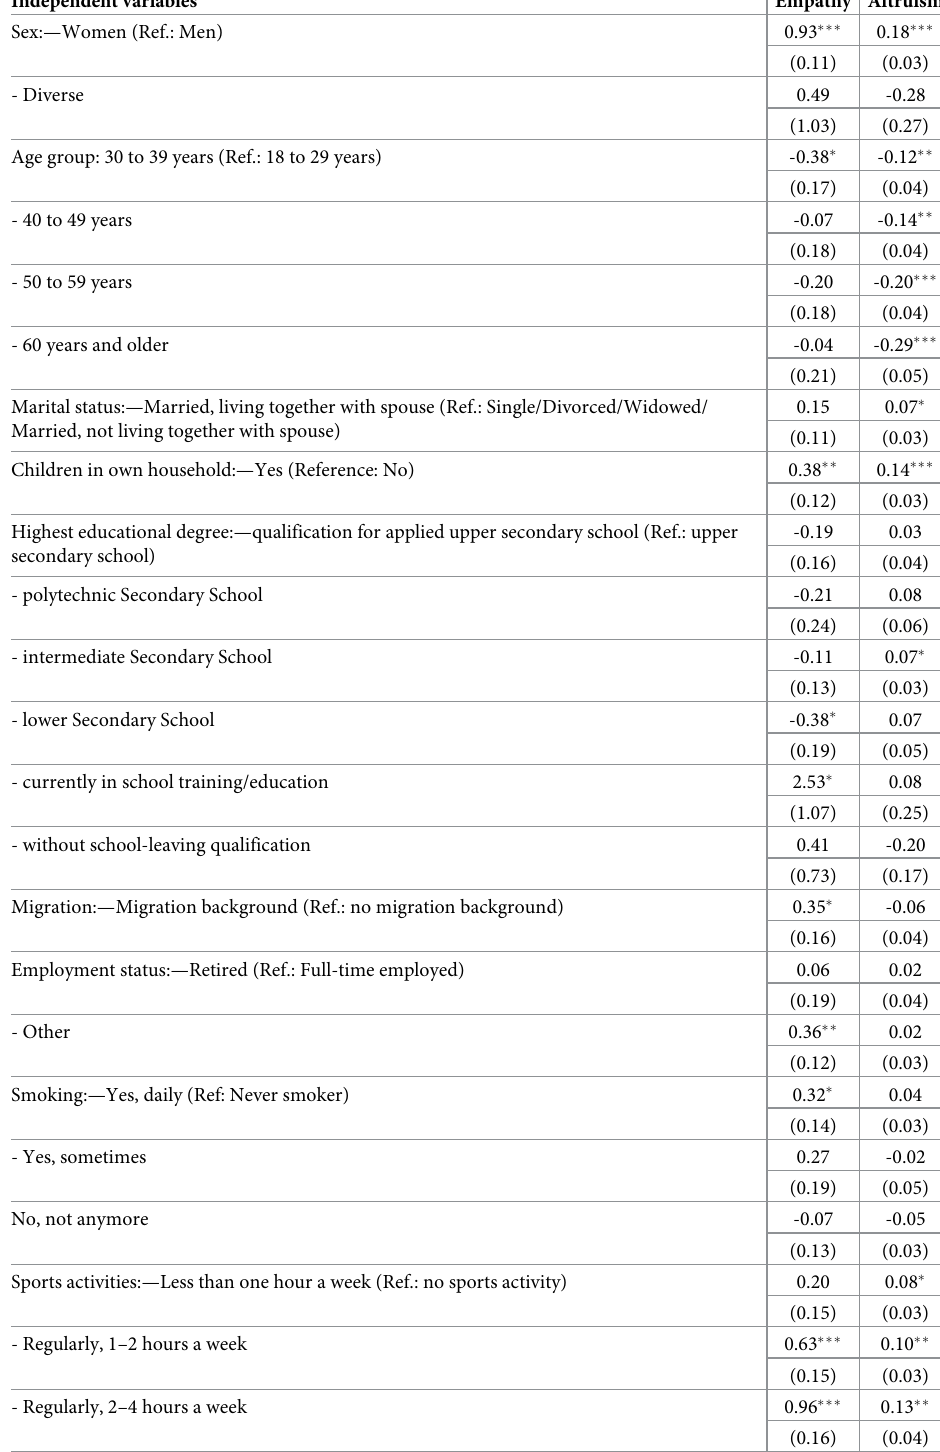
Table 2. Correlates of empathy and altruism. Results of multiple linear